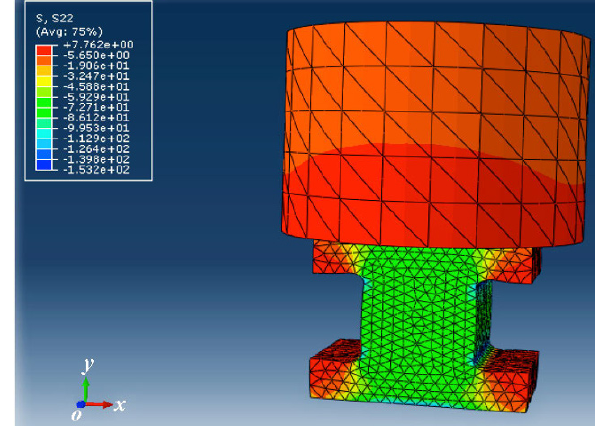
Fig. 2 Finite element model of the elastic I-shaped specimen subjet to unidirectional compression along its vertical axis. Effective part of the beam consists of the central rib with the highest compressive stress. Other parts of the specimen do not contribute to the overall strain and their effect can therefore be